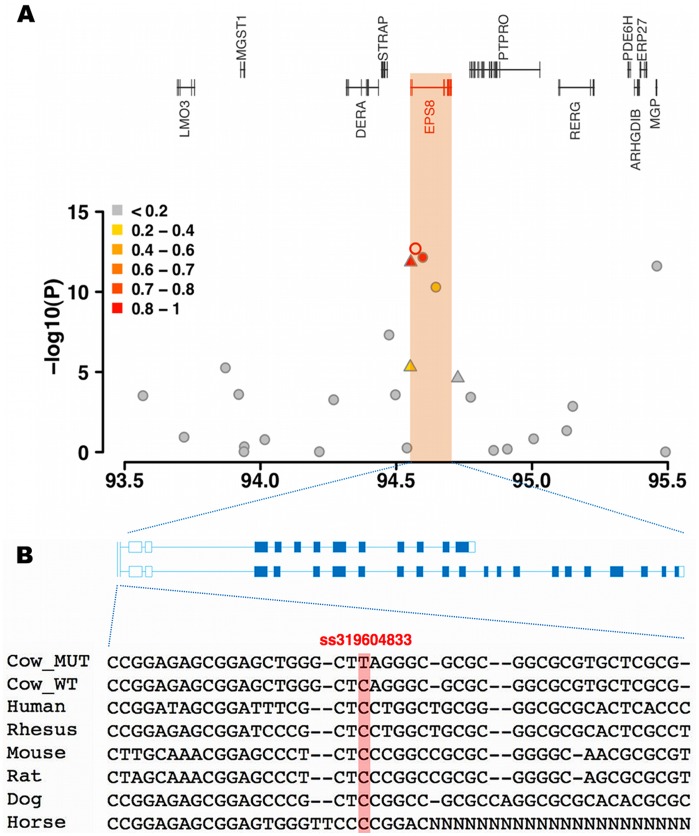
Schematic view of the BTA5 QTL region encompassing EPS8.(A) The open symbol represents the most significantly associated SNP. Different colors indicate the extent of linkage disequilibrium (r2) between the most significantly associated SNP and all other SNPs. Triangles and circles indicate SNPs resulting from re-sequencing and genotyping with the 50 K BeadChip, respectively. (B) Two alternative transcripts of EPS8 are present in cattle. The multispecies sequence alignment of a segment in the promoter region of EPS8 encompassing the highly significantly associated ss319604833 polymorphism (red background) illustrates the high conservation among species.